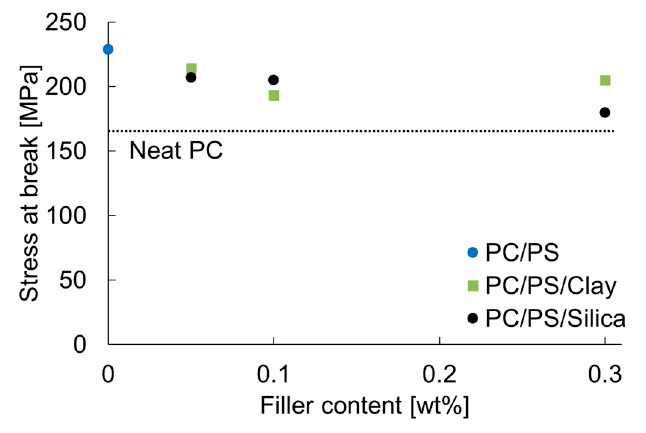
Figure 7. Relation between the elongation at break and stress of expansion.